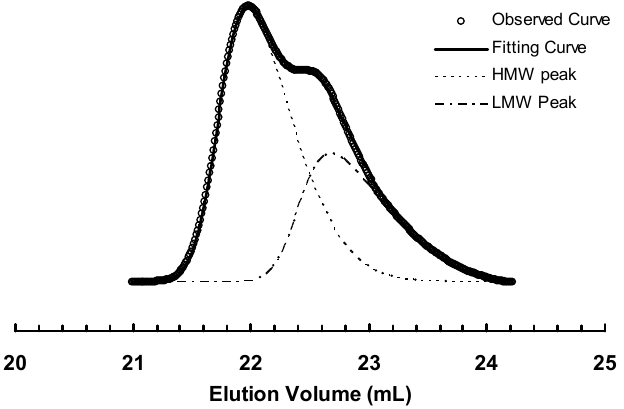
Figure 5. Deconvolution of GPC elution curve for sample 3b-E400-3.